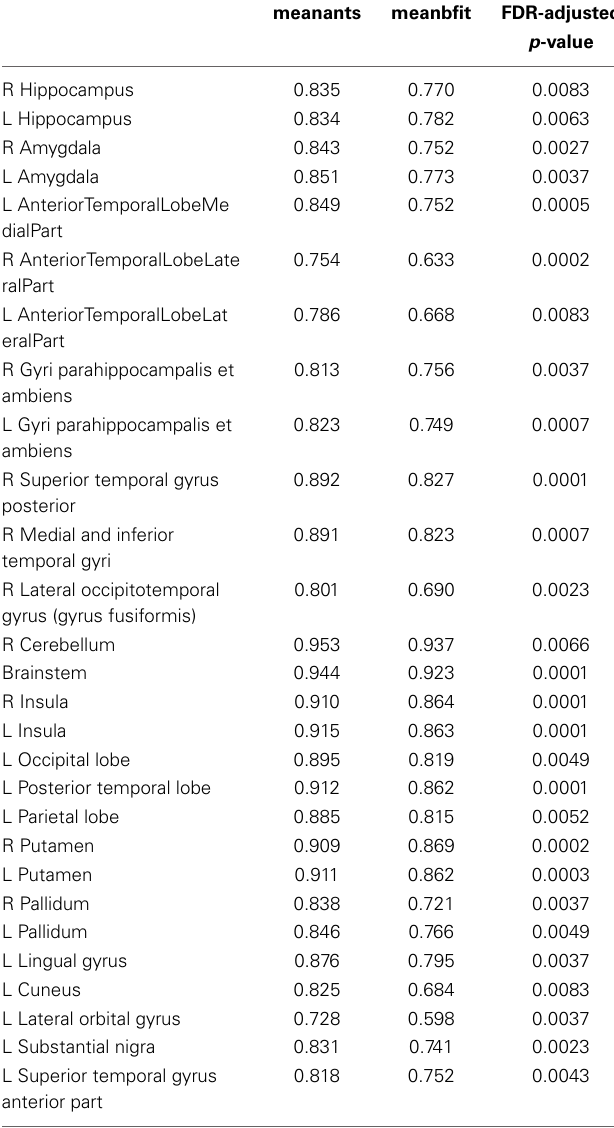
Table 1 | Dice overlap for ANTs and BRAINSFit where only regions with q -value < 0 . 01 are